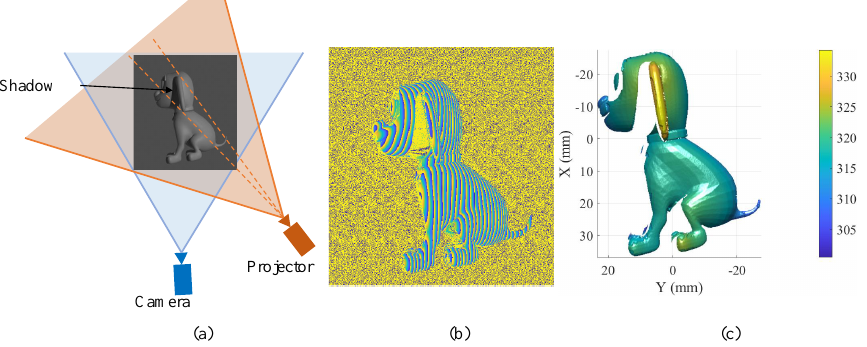
Figure 1. Illustration of the formation of shadows and shadow-induced errors in FPP. ( a ) The formation of shadows; ( b ) Shadow-induced errors in the wrapped phase map; ( c ) 3D reconstructed geometry with